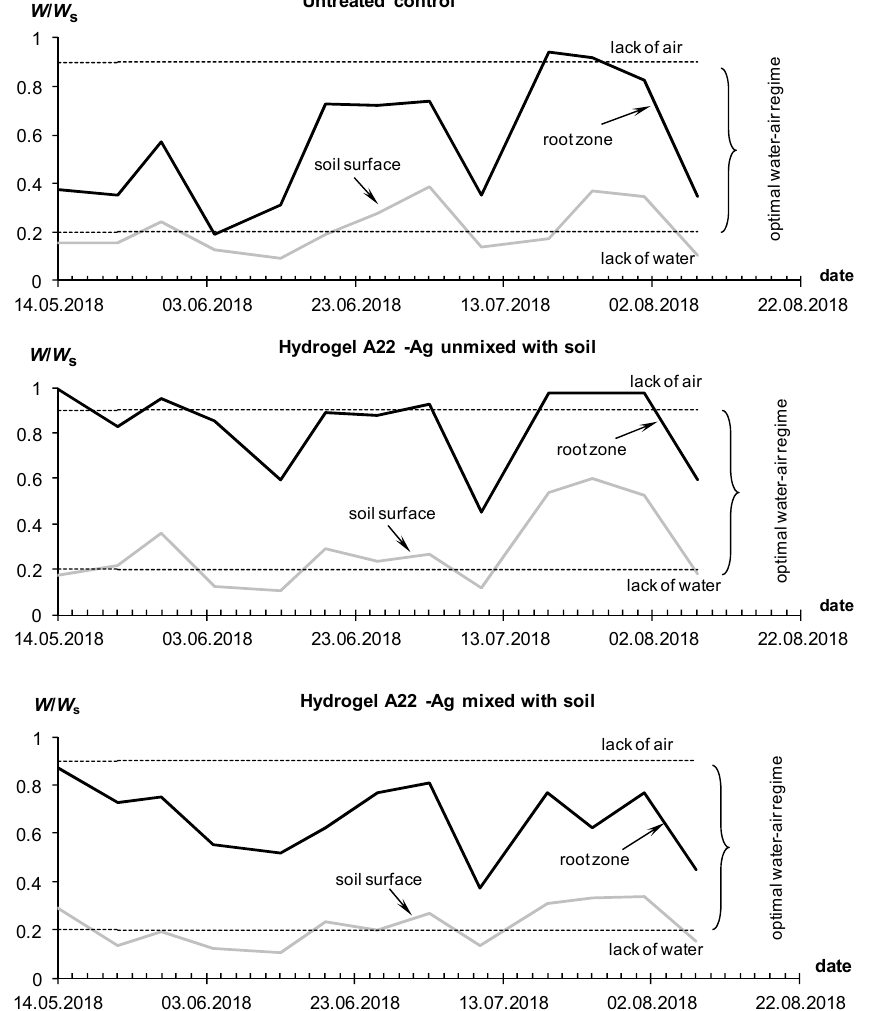
Figure 13. Soil water–air regime under the influence of irrigation and gel-forming conditioners (Moscow region, Retisol, drip irrigation, 2018). The dotted lines are the critical limits of the optimal values for the W / W s index (see Figure 9).